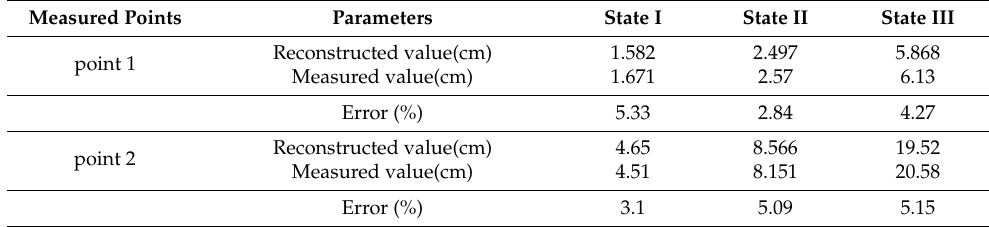
Table 11. Comparison of the results of the measurement points in Figure